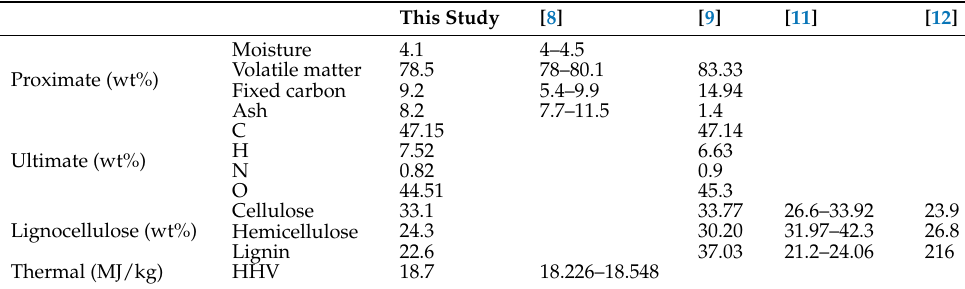
Table 1. Physicochemical and thermal properties of date